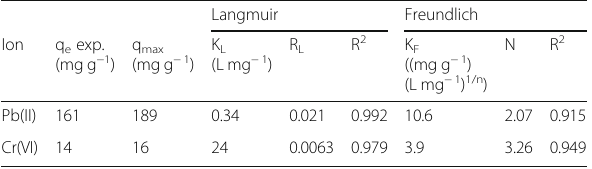
Table 2 Various isotherms parameters of Pb(II) and Cr(VI) ions adsorption onto CSM/SA hybrid beads